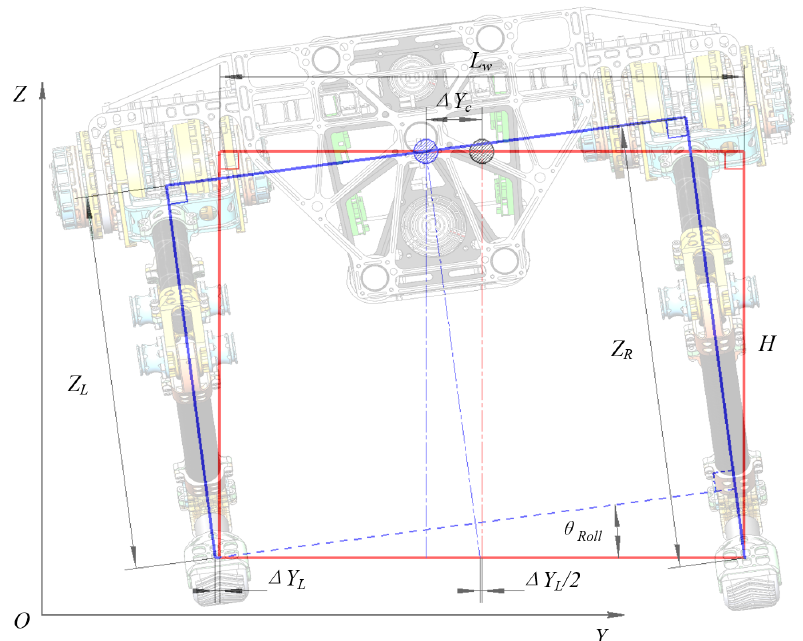
Figure 9. Rear view of a planar quadruped robot with trunk swaying. The red solid line represents the original posture, the blue solid line represents the posture after trunk swaying, and the circle with the section line represents the CoM